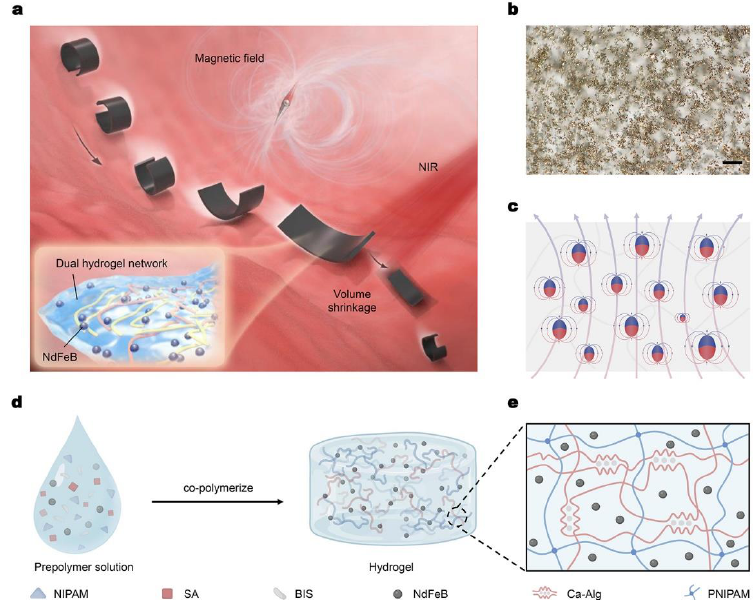
Figure 1. Magnetic/NIR-sensitive hydrogel millirobot for controllable movement and deformation. ( a ) Conceptual schematic of a magnetic/NIR-sensitive hydrogel millirobot in the intestinal environ- ment. The millirobot curves its body and rolls in the magnetic field while shrinking the whole volume in response to the NIR illumination. The inset is the composition of magnetic hydrogel material, including a dual hydrogel network with NdFeB magnetic particles randomly dispersed. ( b ) Optical image of magnetic hydrogel material, and the magnetic particles are dispersed randomly in the material. Scale bar: 100 µ m. ( c ) Illustration of magnetic moment distribution after the magnetization process. ( d ) Schematic for the fabrication process of the magnetic/NIR-sensitive hydrogel material. ( e ) Theoretical structure of dual-network hydrogel, composed of crosslinked PNIPAM and Ca-Alg with an interpenetrating polymer